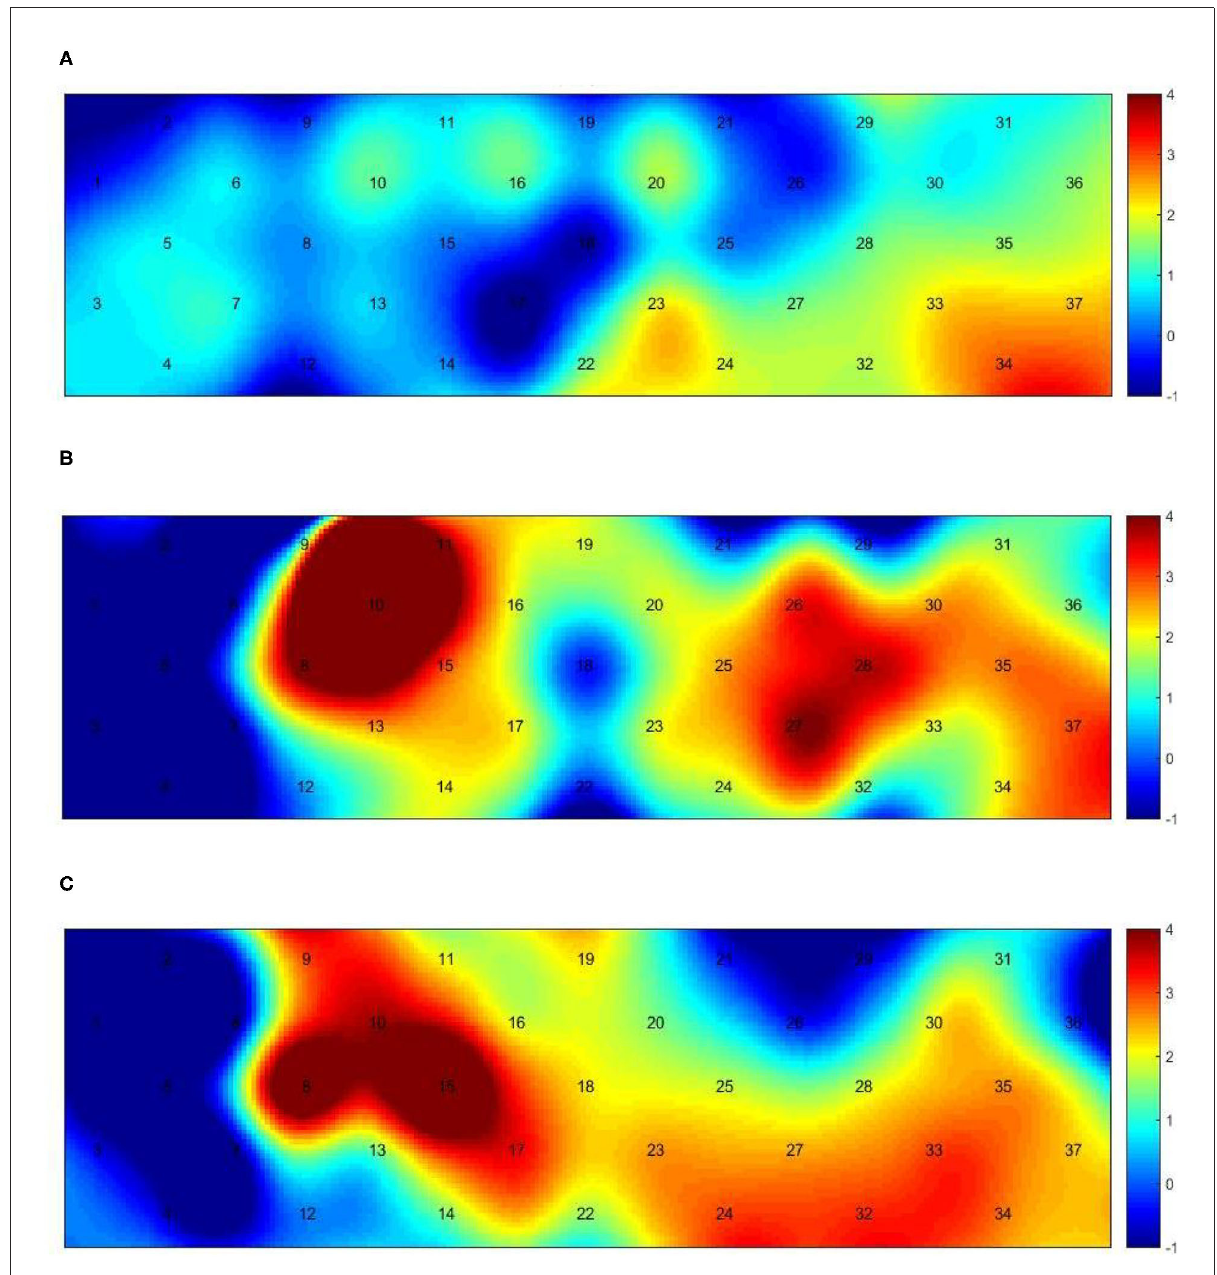
FIGURE4 Group-level channel activation t-map in the gait task ( p < 0.05, uncorrected). (A) Healthy treadmill walking, (B) hemiplegic treadmill walking, and (C) hemiplegic treadmill walking with FES assistance.